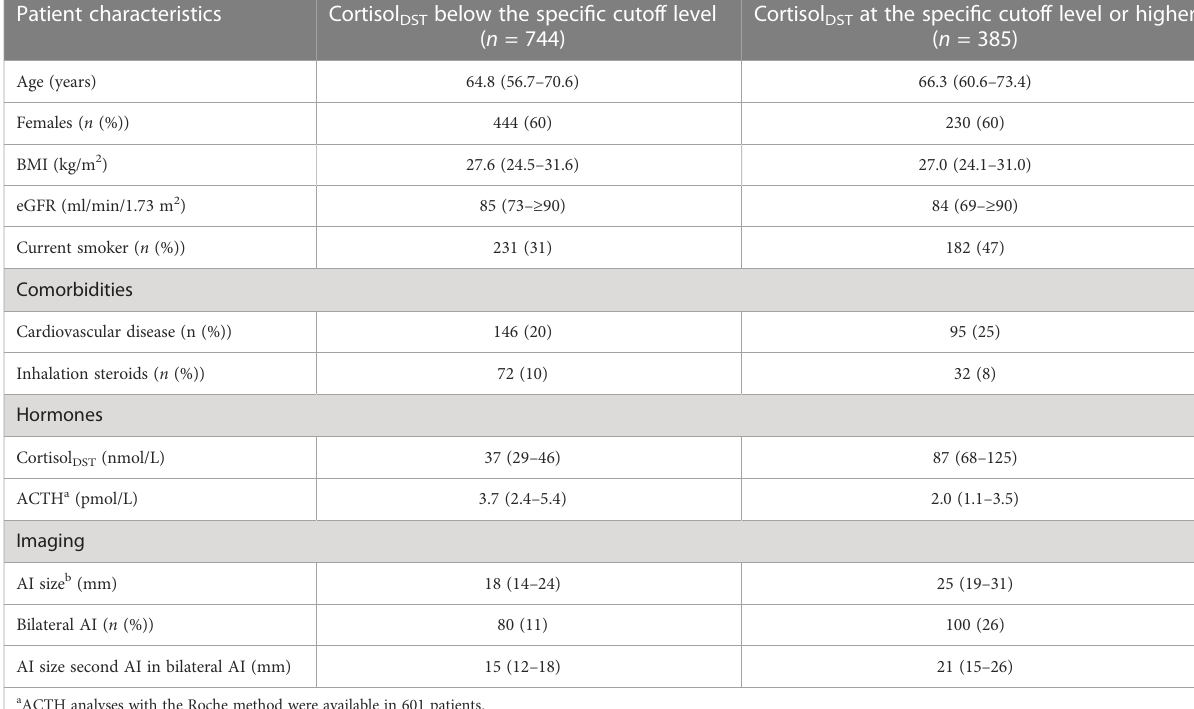
TABLE 6 Characteristics of patients, according to whether they had cortisol DST above the proposed age-, BMI-, and eGFR-adjusted cutoff levels. Patient